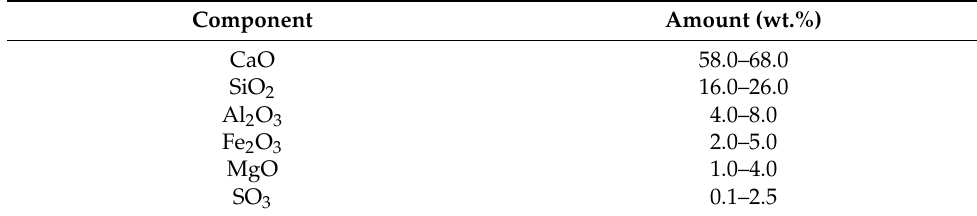
Table 2. Chemical composition of OPC